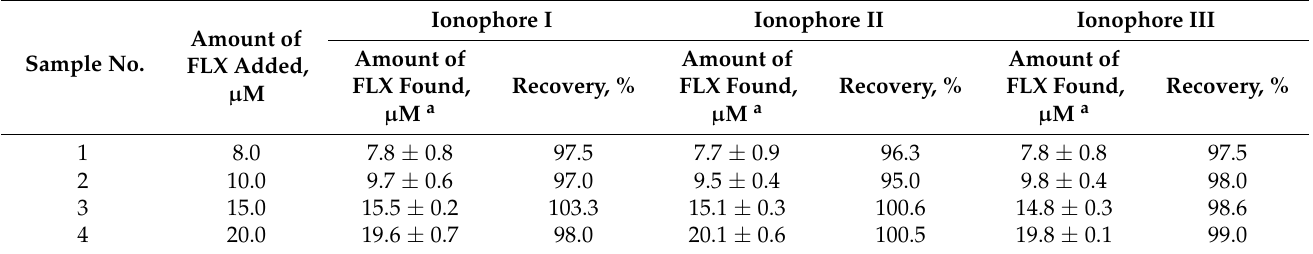
Table 8. Potentiometric assessment of FLX in different spiked serum